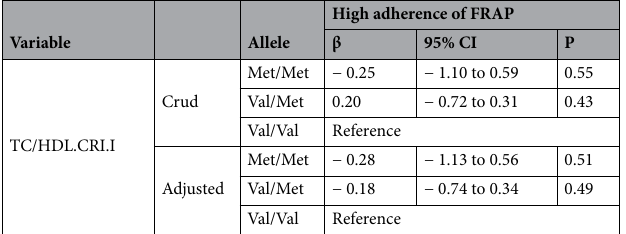
Table 4. The interaction of BDNF Val/Met polymorphism and FRAP on anthropometric indices, lipid profile and atherogenic indices. Val/Val genotype is considered as a reference. Low adherence of DTAC is considered as a reference. Generalized linear model; crude model and adjusted model Age, physical activity, sex, smoking, alcohol, energy intake, lipid, and glucose-lowering medicines, and family history of diabetes, as covariates. Bold values denote statistical signifcance at the P < 0.05 level. FRAP ferric reducing ability of plasma, CI confidence interval, AIP (Atherogenic index of plasma): log(TG/HDL), AC (Atherogenic coefficient): (TC-HDL/HDL), CRI-II (Castelli s risk index): LDL/HDL, CRI-I (Castelli s risk index): TC/HDL, TC total cholesterol, TG triglyceride, HDL high density lipoprotein, LDL low density lipoprotein, WC waist circumference.